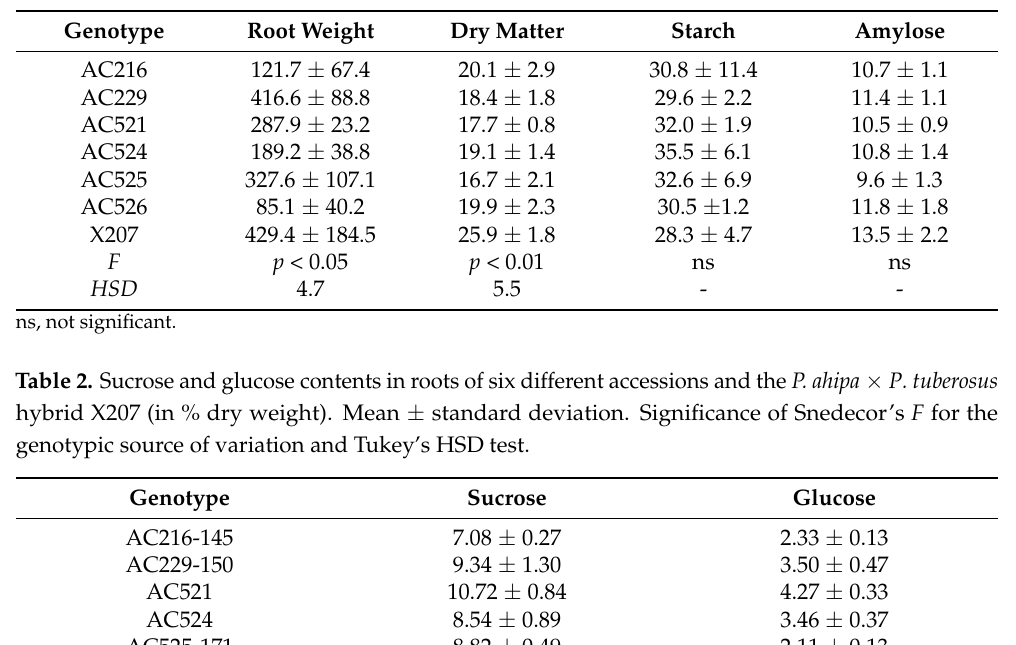
Table 1. Root weight (g plant − 1 ) and root dry matter, starch, and amylose content (in % dry weight) in six different ahipa accessions and the X207 P. ahipa × P. tuberosus hybrid. Mean ± standard deviation. Below, significance of Snedecor’s F for the genotypic source of variation and Tukey’s HSD test.